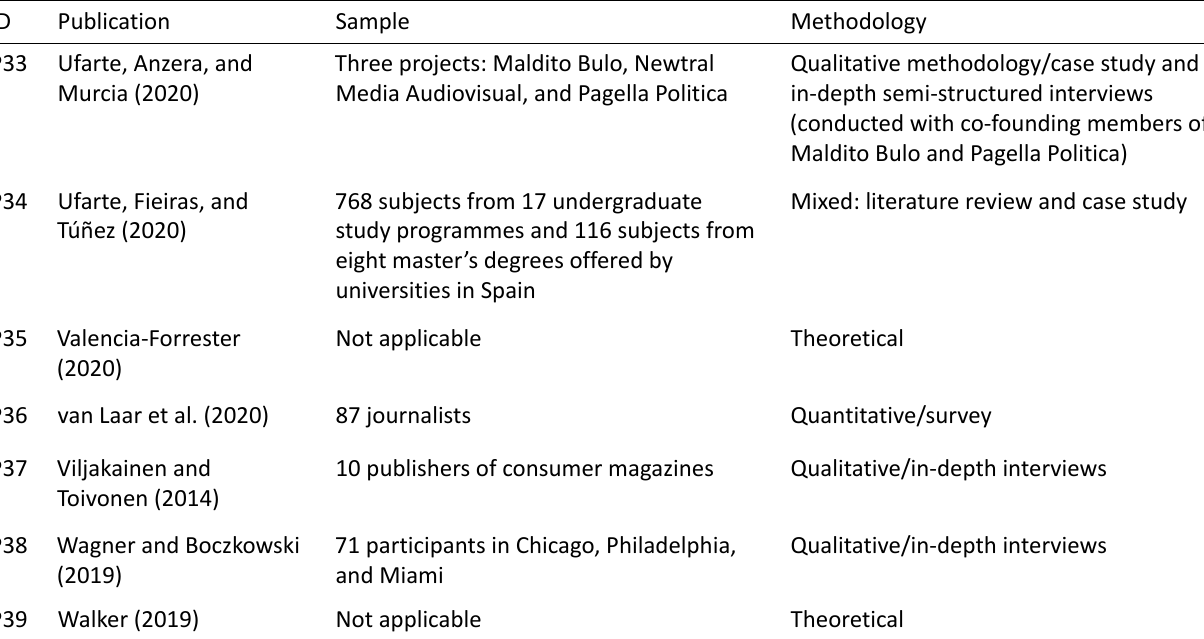
Table 2. (Cont.) Main characteristics of the publications included in the qualitative